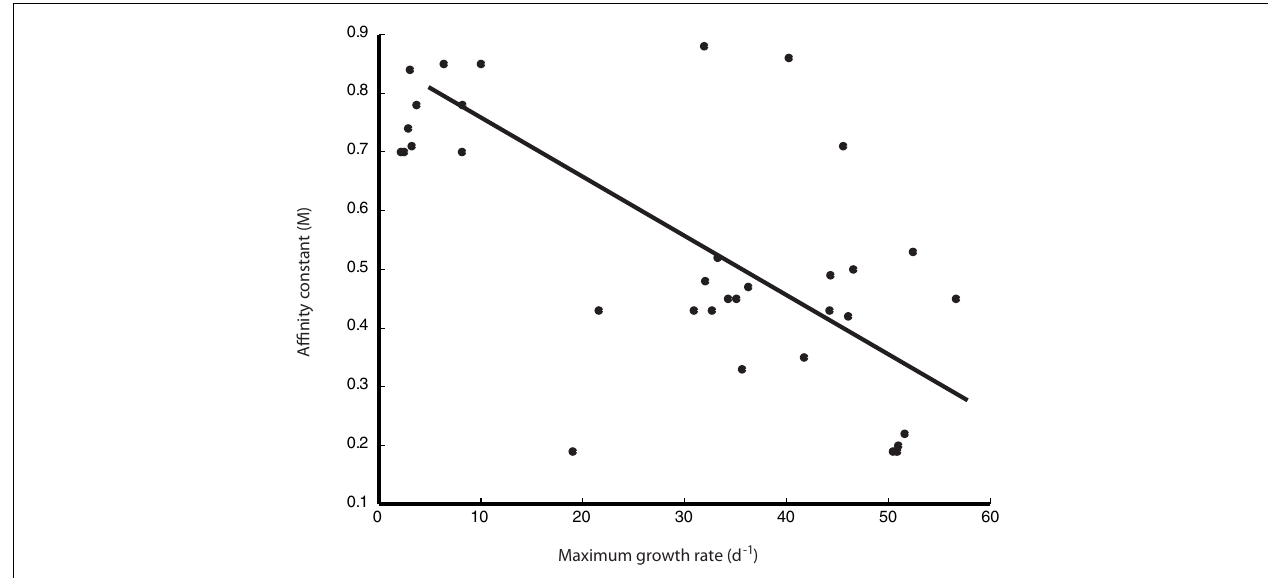
FIGUREA3 | Explicit relationship between trait parameters K M and µ max .